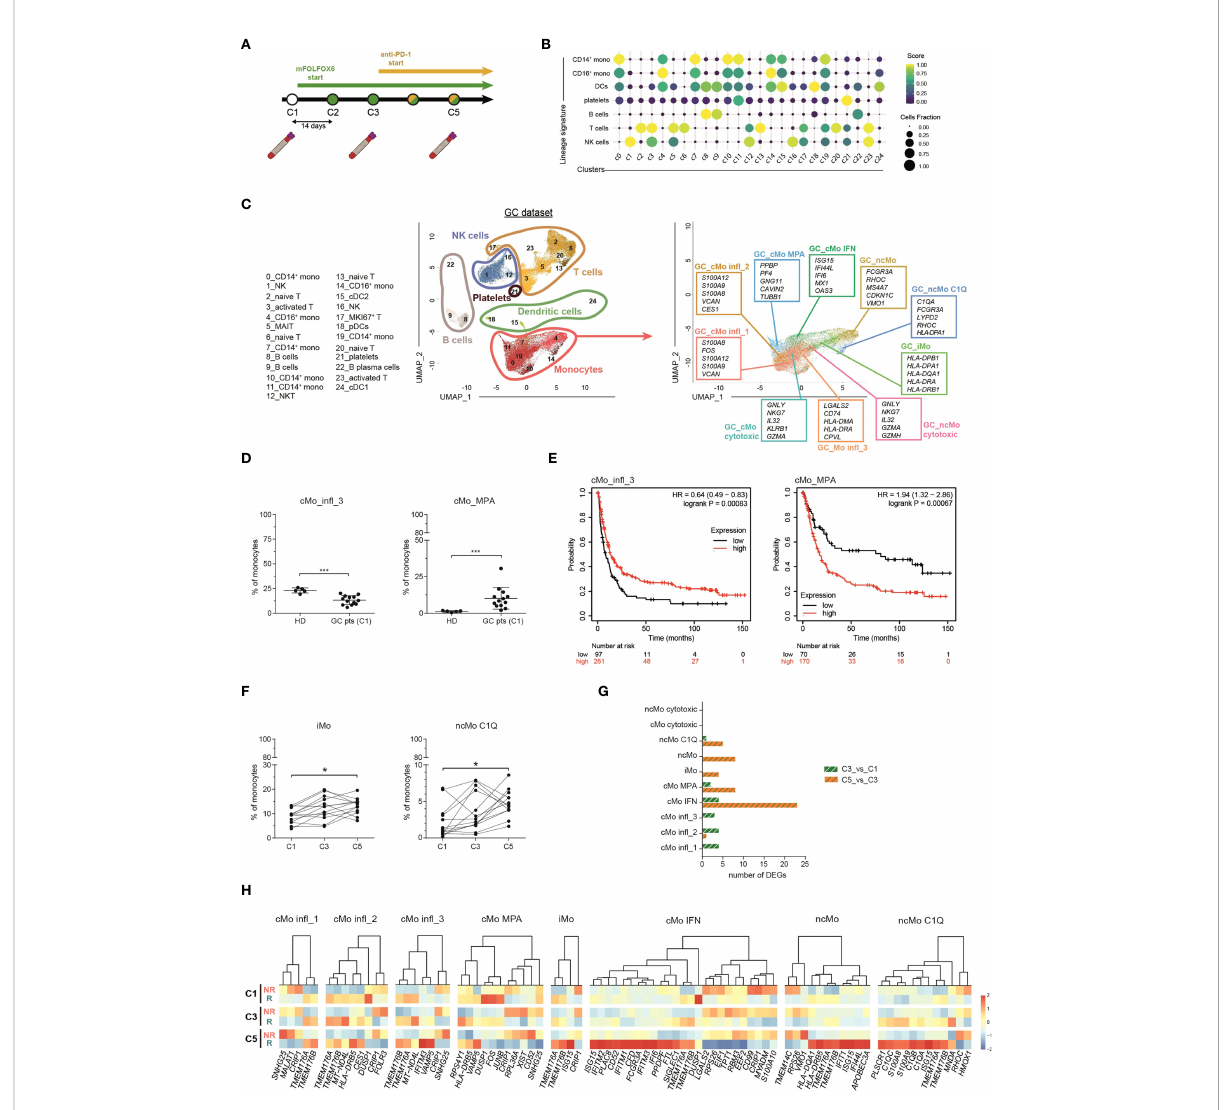
FIGURE 4 Monocyte subsets in advance gastrointestinal cancers and response to immunotherapy. (A) Schematic illustration of the clinical trial treatment strategy adopted in the study of Grif fi ths and colleagues (Mod. from Grif fi ths et al., PNAS, 2020). Advanced GC pts received mFOLFOX6 chemotherapy at the beginning of the trial for 2 cycles (14 days per cycle). From cycle 3 through 12, they received the combination of mFOLFOX6 and anti-PD-1 immunotherapy. Blood samples were collected at C1 (cycle 1, baseline), C3 (cycle 3) and C5 (cycle 5). PBMCs were isolated and frozen. Single cell RNA sequencing was performed on the cryopreserved PBMCs samples using 10X Genomics technology and sequenced on an Illumina HiSEq. (B) Dot-plot showing annotated immune cells by lineage signatures (genes belonging to each signature are listed in Table S4). ssGSEA score-based signature expression is colored-coded from blue (lower) to yellow (higher); circle size indicates the fraction of cells expressing the signature. ( C , left) UMAP projection of GC pts PBMCs (n = 55,293) showing 25 clusters individually annotated belonging to 6 major immune cell subsets. Clusters are numbered according to their size, from the largest (cluster 0) to the smallest (cluster 24). Each dot represents an individual cell. ( C , right) UMAP projection of GC pts monocytes clustered using the machine learning classi fi er. Up to fi ve cluster marker genes are listed in boxes next to each cluster. Cluster marker genes are de fi ned as in Material and Methods. (D) Percentage of cMo_in fl _3 and cMo_MPA over the total monocyte population from healthy donors and GC pts at C1. Statistical signi fi cance was determined by the Mann-Whitney test. (***) P < 0.001. (E) Kaplan-Meier curves of patient fi rst progression survival de fi ned by the cMo in fl _3 signature (left) or the cMo MPA signature (right) using KMplot (34). Signi fi cance was evaluated by the log-rank Mantel – Cox test. (F) Percentage of iMo and nc_Mo C1Q over the total monocyte population in GC pts during therapy. Each line represents a patient percentage trend along the three therapy cycle steps. Statistical signi fi cance was determined by the Friedman test followed by Dunnett ’ s multiple comparison test. (*) P < 0.05. (G) Bar plot showing the number of signi fi cant differentially expressing genes after immunotherapy (green and white bars) and immunotherapy (orange and green pathways) in monocyte subtypes. (H) Heatmap showing the gene expression in C1, C3 and C5 of signi fi cant differentially expressing genes between responders and non-responders after immunotherapy. Gene expression is colored-coded from blue (lower) to red (higher); gene expression level is scaled by columns. C1, cycle 1 = baseline; C3, cycle 3 = chemotherapy mFOLOFX6 regimen; C5, cycle 5 = chemotherapy + anti – PD-1 immunotherapy. HD, healthy donors; GC pts, gastrointestinal cancer patients. NS, non-responder patients; R, responder